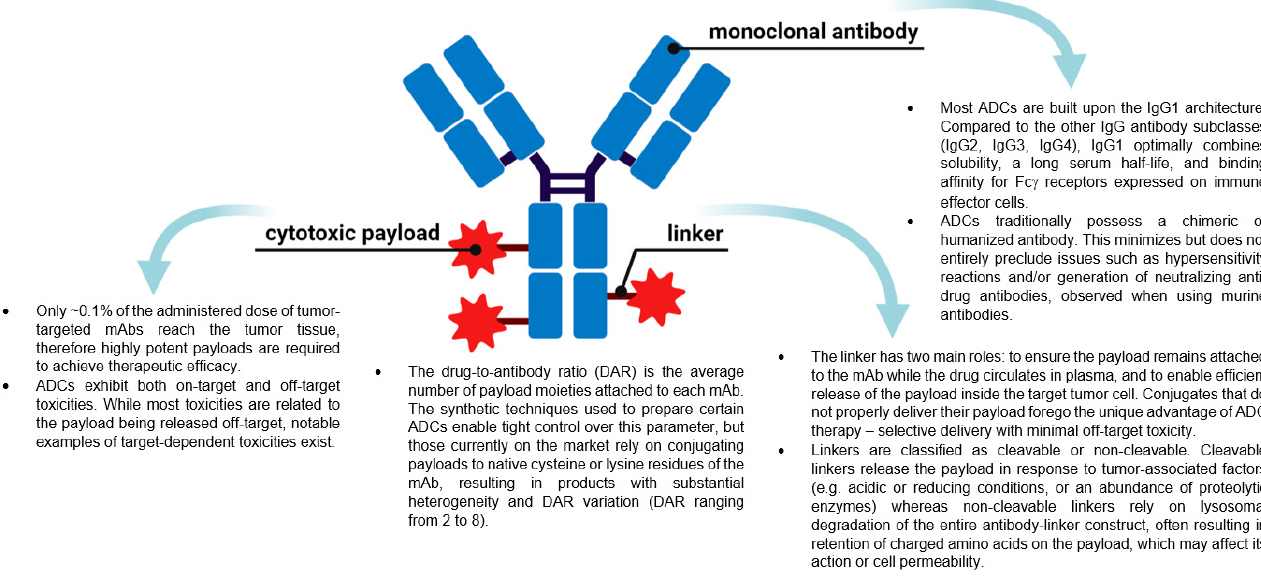
Figure 1. The general structure of an antibody-drug conjugate (ADC) and key points about the different components. (Created with BioRender.com, accessed 27 September 2021).